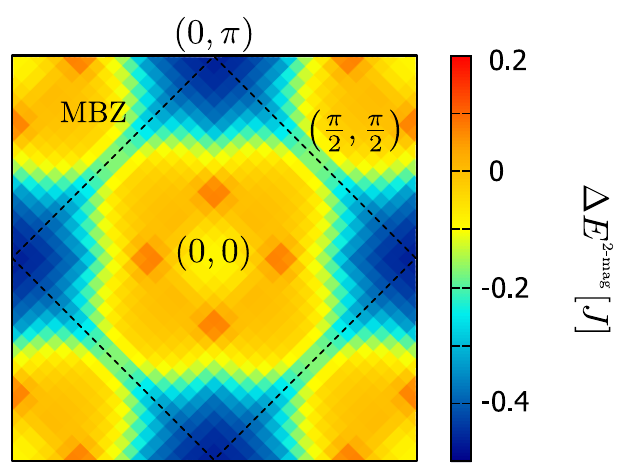
Figure 8: Energy difference as defined in Eq. (26) between the lowest energy level in the longitudinal channel, i.e., between one α -magnon and one β -magnon, with and without in-